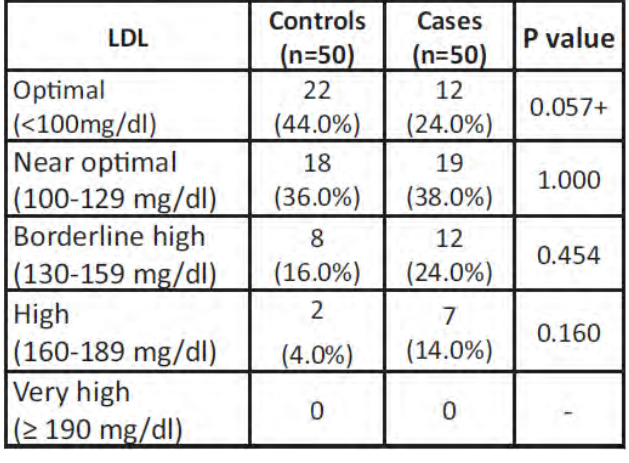
Table 5: Comparison of